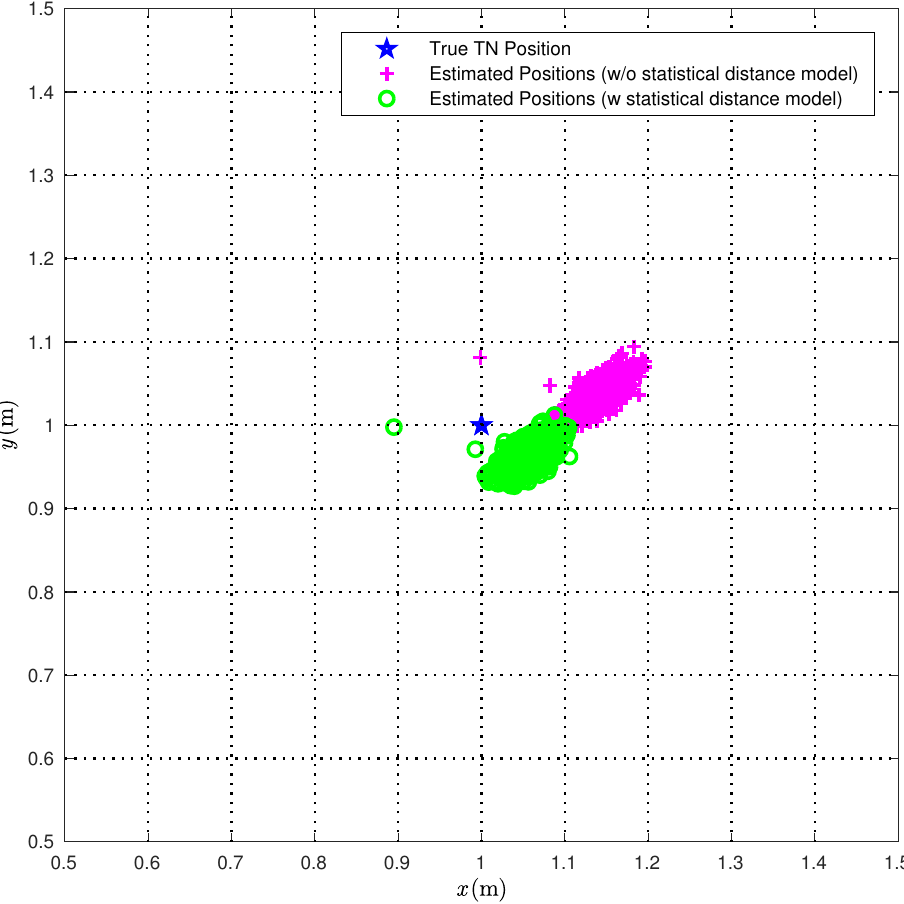
Figure 12. The 1000 position estimates obtained with the TSML localization algorithm are shown (magenta plus), together with the 1000 position estimates obtained when taking into account the statistical model for range estimates (green circles) and the TN (blue